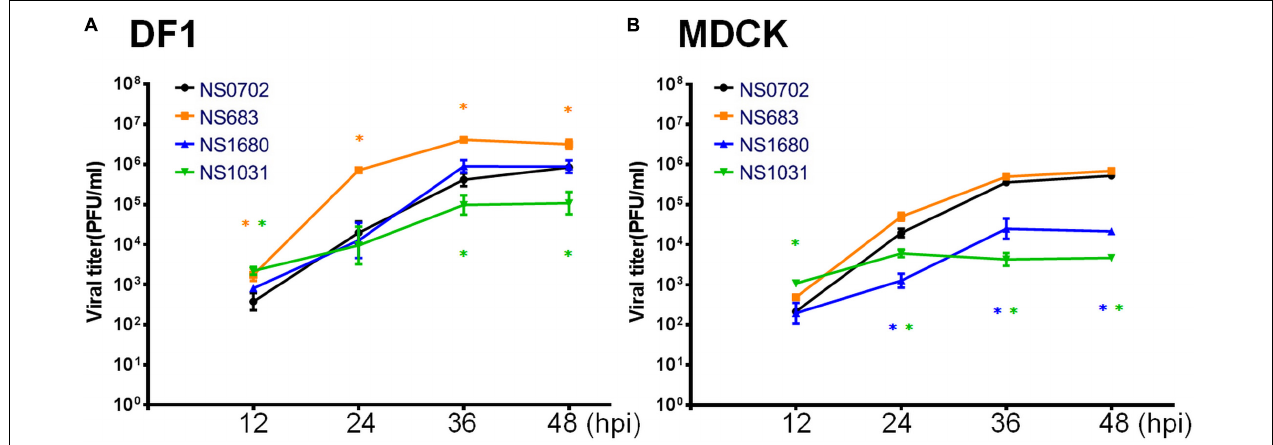
FIGURE 3 | Growth kinetics of reassortant avian influenza virus (AIVs) in cells. (A) DF-1 or (B) Madin–Darby canine kidney (MDCK) cells were infected with one of four reassortant viruses at a 0.01 multiplicity of infection (MOI), and the yield of viral progeny was determined at 12, 24, 36, and 48 h post infection (hpi) by standard plaque assay [plaque-forming units (PFUs)/ml). The mean yields and standard error of triplicate experiments are displayed. *Indicates a significant difference ( p < 0.05) between yield of the progeny and parental virus (NS0702).